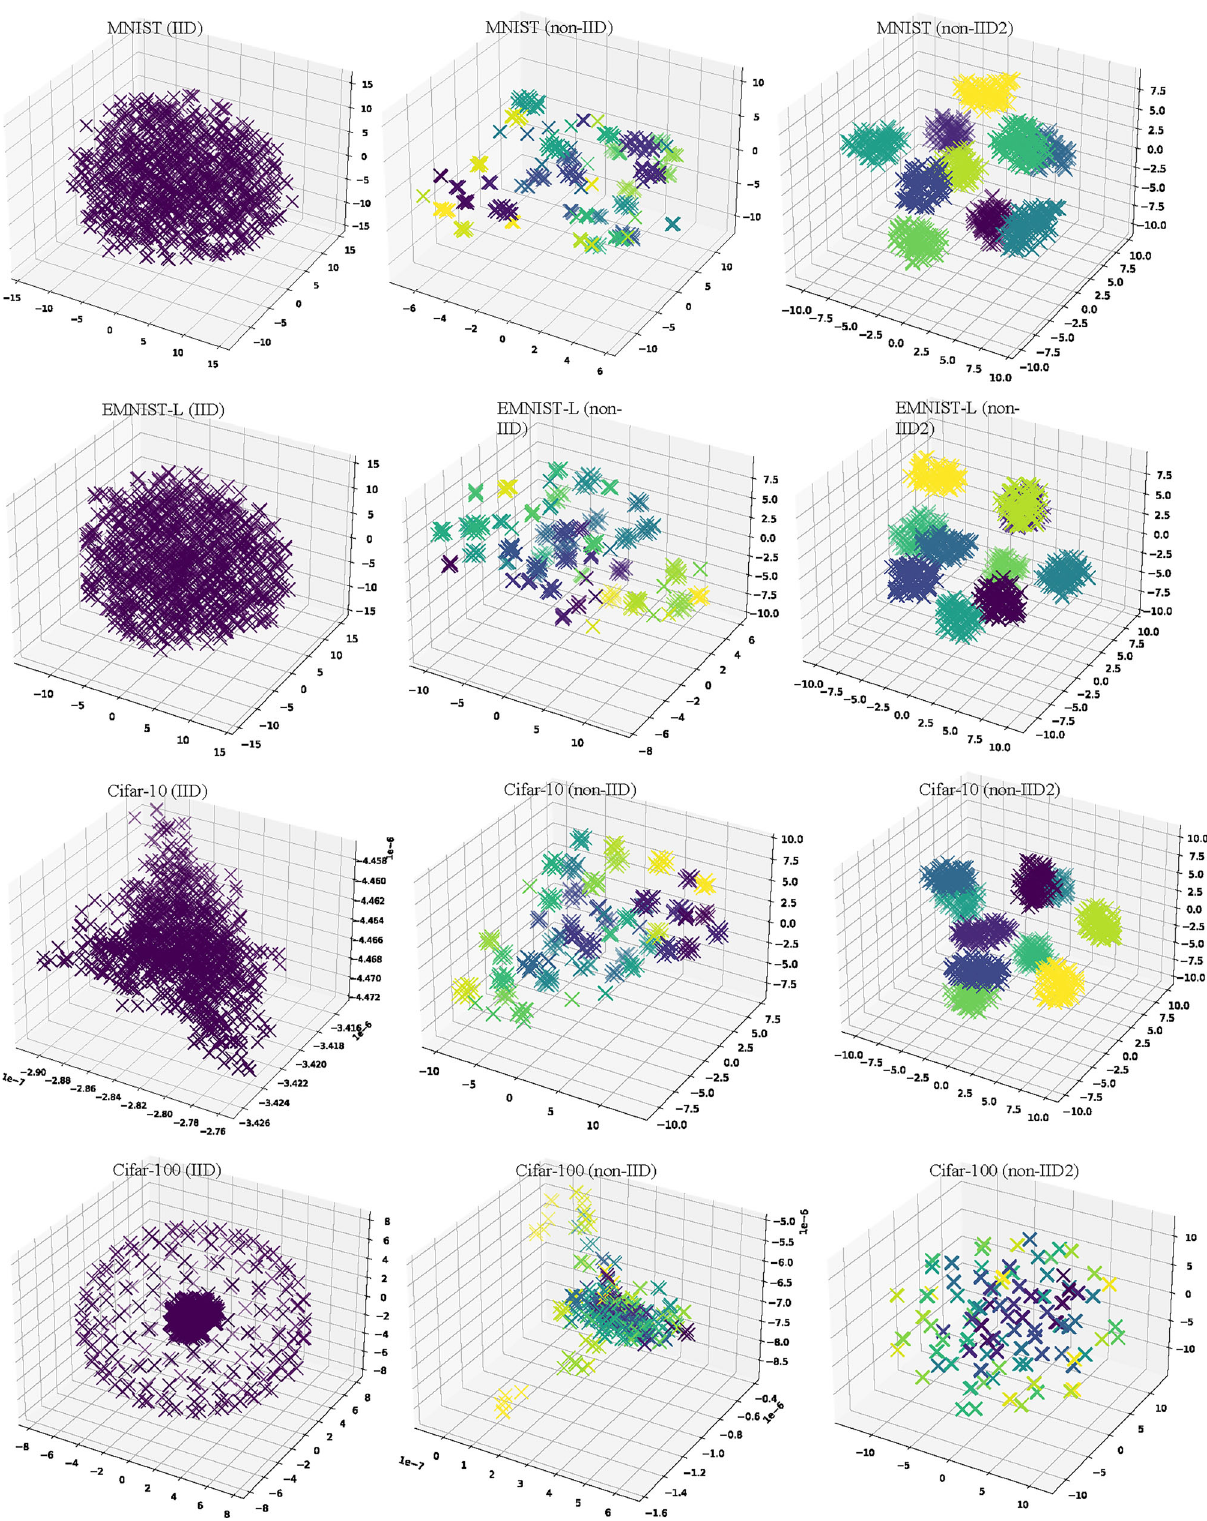
Fig. 10 Clustering results of MNIST, EMNIST-L, Cifar-10 and Cifar- 100 under the condition of massive client scale and different data heterogeneity: For the IID split, all clients have the same data distri- bution and all clients belong to the same set. For the non-IID split, clients are divided into 131 clusters in MNIST,133 in EMNIST-L, 120